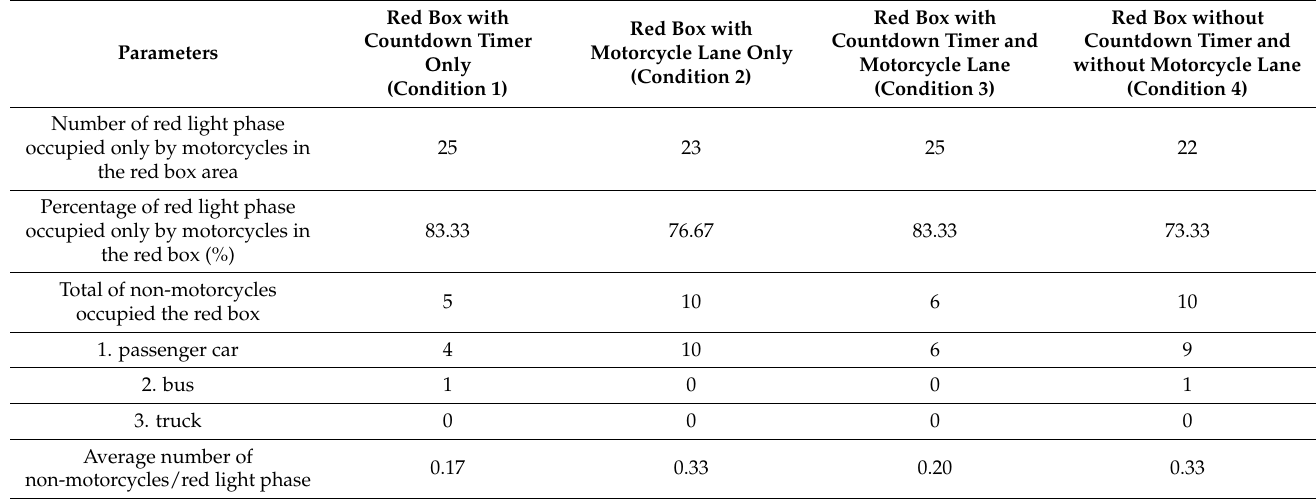
Table 4. Red box occupation by motorcycle and other motorized